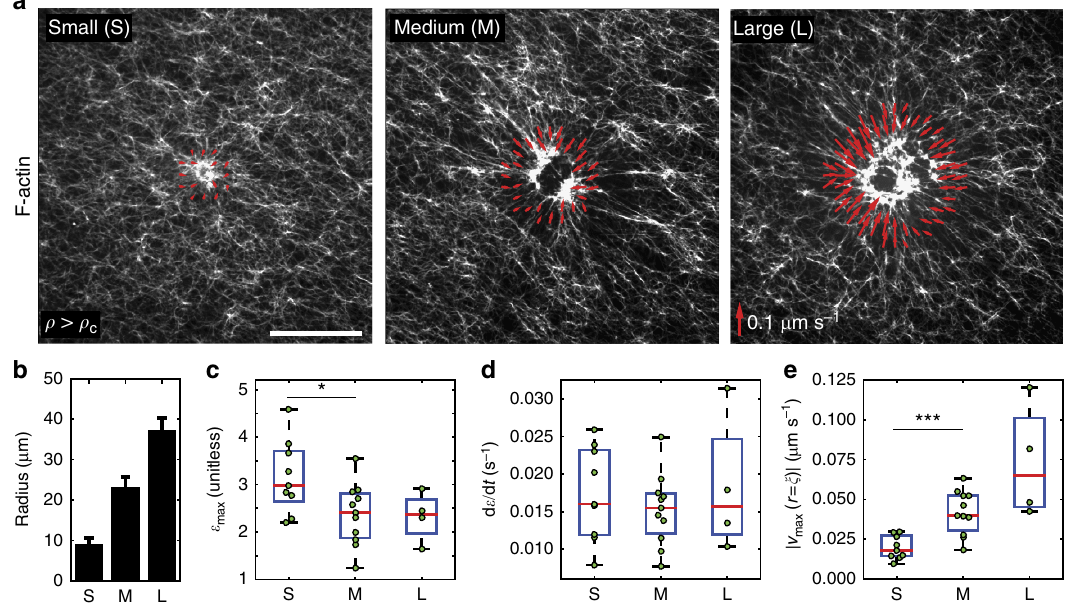
Figure 4 | Actomyosin contraction is telescopic. ( a ) Actomyosin network contraction for activation regions of varying size: small (left), medium (middle) or large (right). Red vectors are boundary velocities at the time point of maximum contraction in each experiment. Scale bar, 25 m m. ( b ) Average radii of the activation regions. The error bars (s.d.) correspond to averaging over different illumination regions of slightly different sizes. ( c ) The maximum contractile strain ( e max ) for each size of activation region. ( d ) Strain rate (d e /d t ) for activation regions. ( e ) Velocity of contraction measured at the boundary of the activation region. * P o 0.05 and *** P o 0.001 by a Student’s t